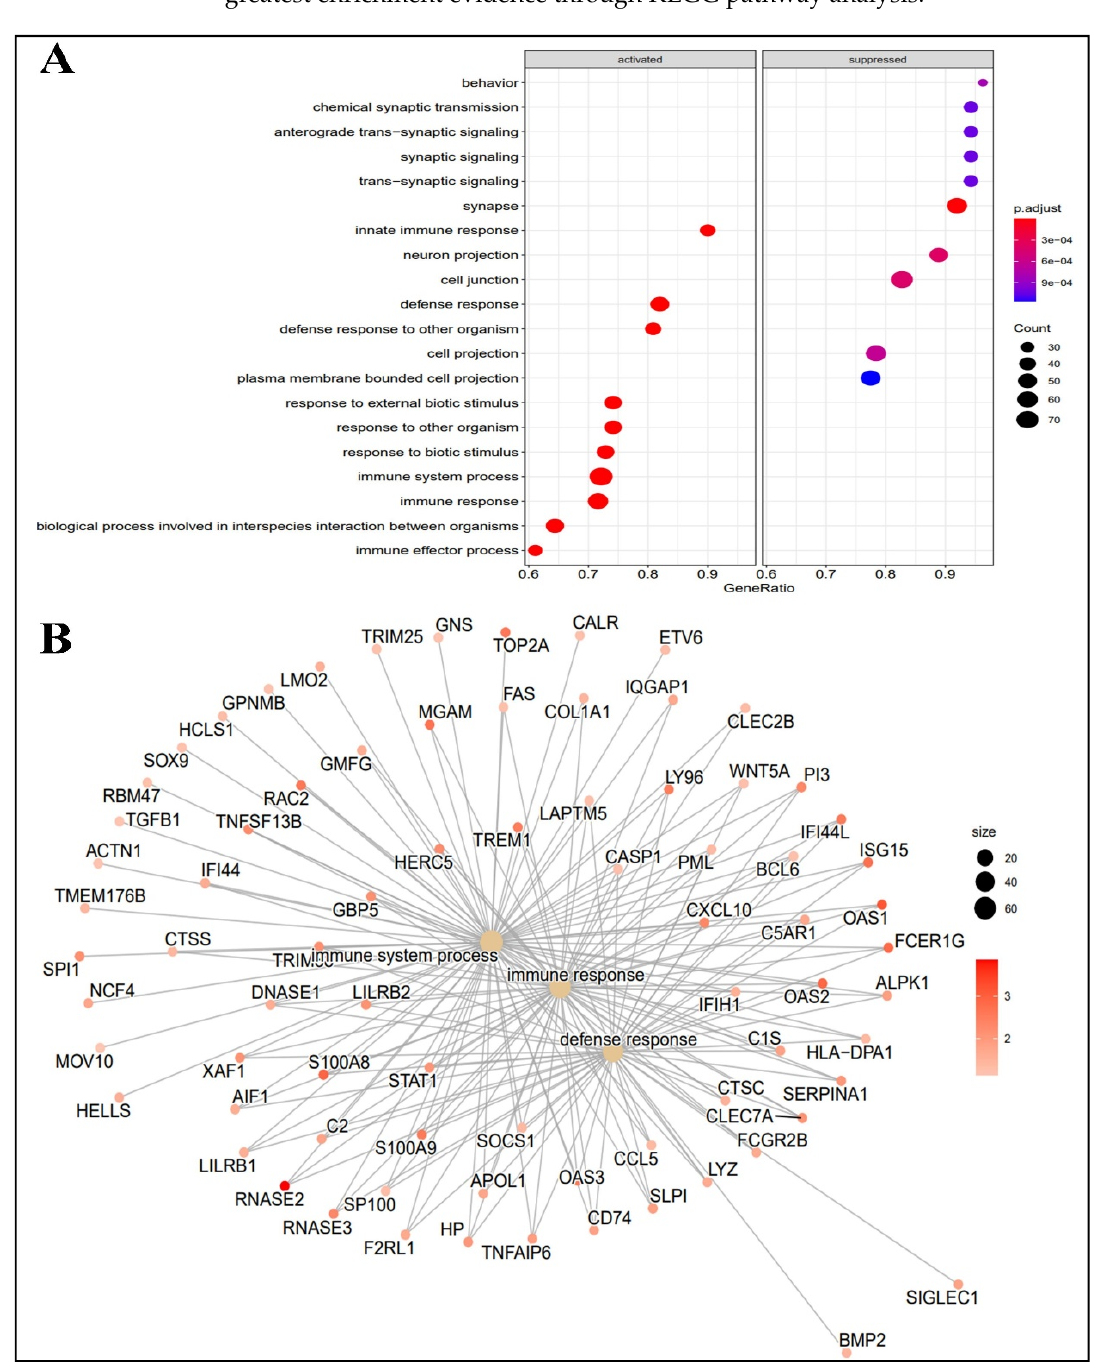
Figure 2. ( A ) Profiling of biological processes, molecular function, cellular components, and their expression status (activated, suppressed), ( B ) Major biological processes and response representa- tion according to their fold change value, greater diameter, and darkness of color indicated major involvement between GBM and COVID-19 comorbidity.